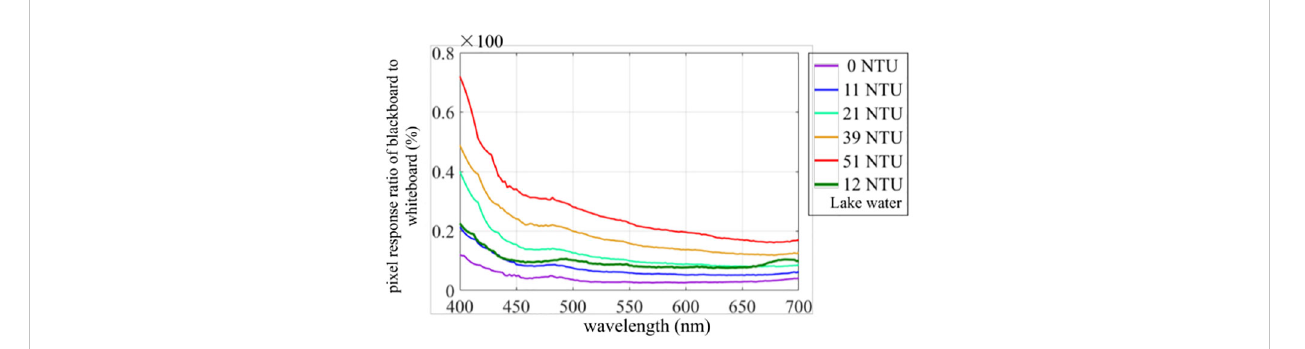
FIGURE 4 Pixel-based spectral response ratio of blackboard and whiteboard under varying turbidity conditions of the water